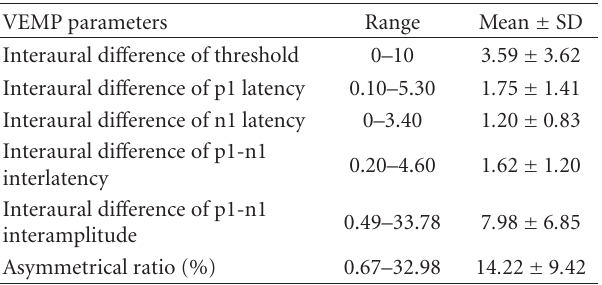
Table 2: Interaural di ff erences of VEMP parameters in 39